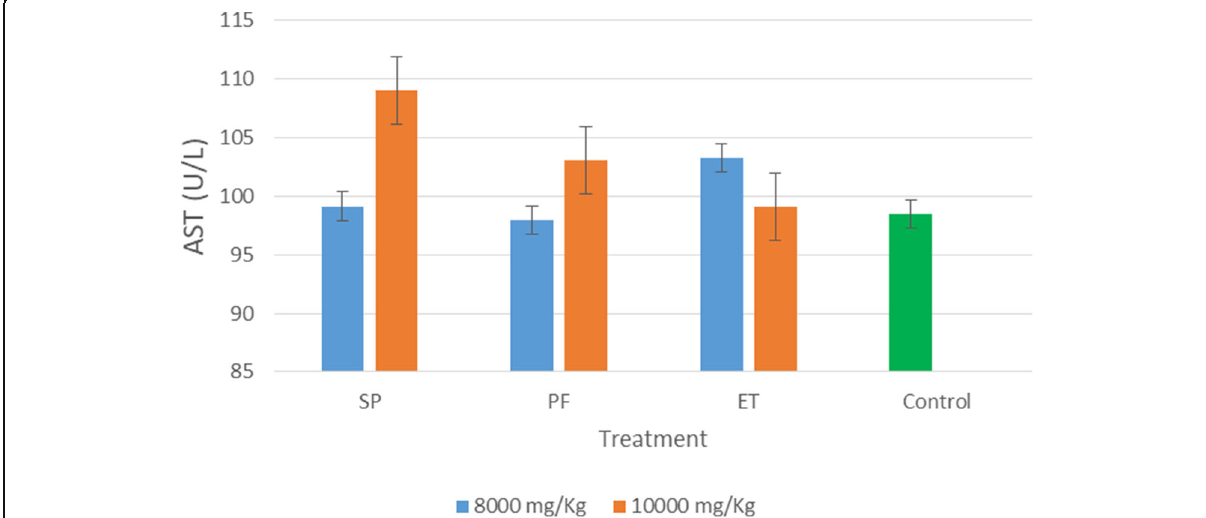
Fig. 3 Effect of the aqueous plant extracts on the levels of aspartate aminotransferase in the